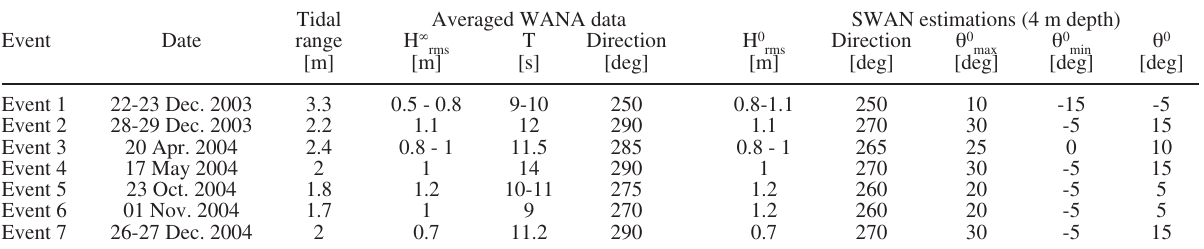
Table 2. – Cusp characteristics after complete formation of the events: wave length λ